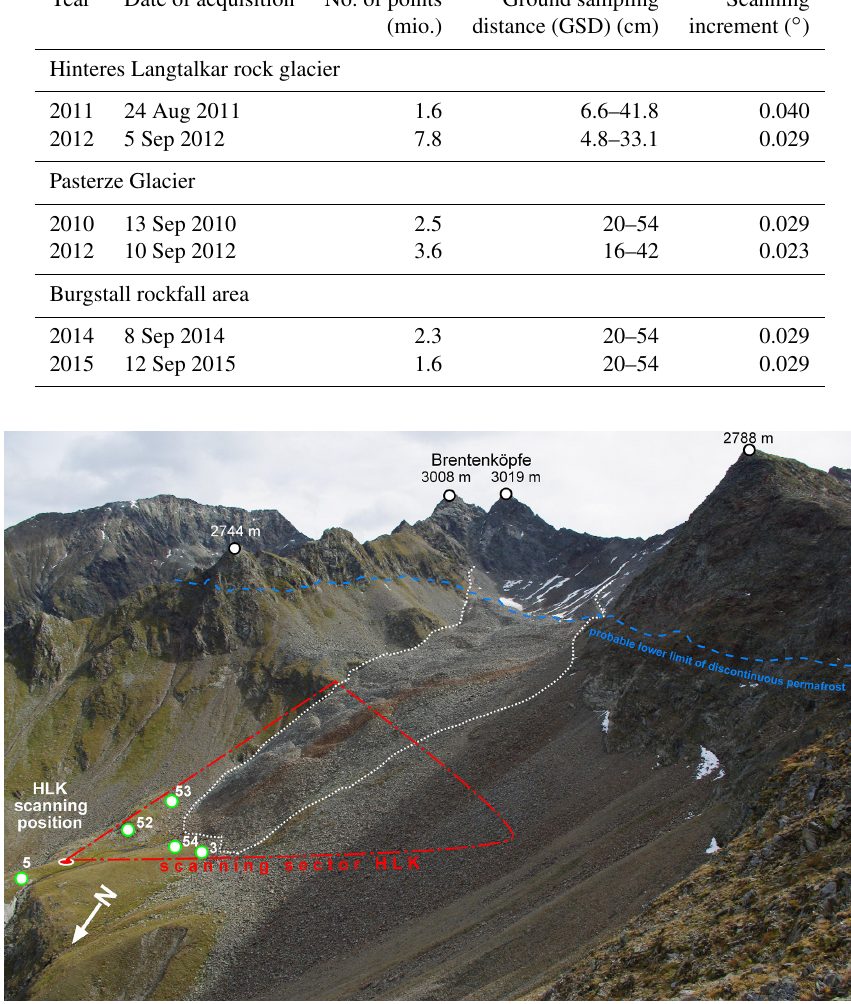
Figure 4. Scanner configuration at Hinteres Langtalkar rock glacier. The scanning position Hinteres Langtalkar (HLK) is indicated by a red ellipse with a white edge; the rock glacier outline is indicated by a white dashed line. White circles with green edges highlight reference